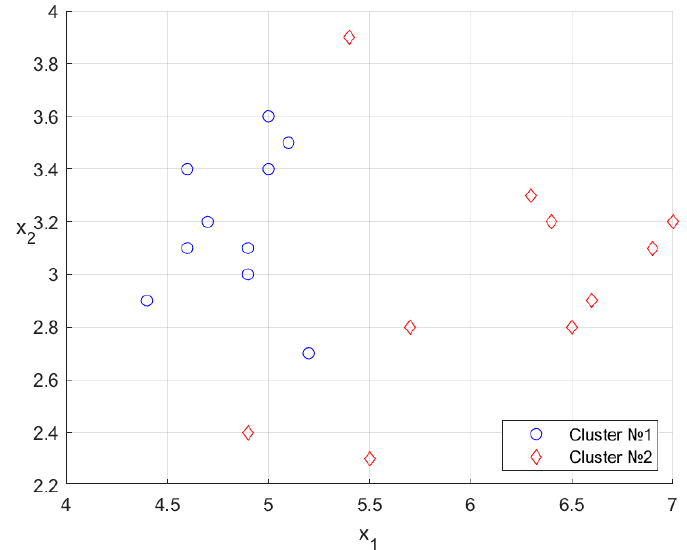
Figure 6. Randomized clustering